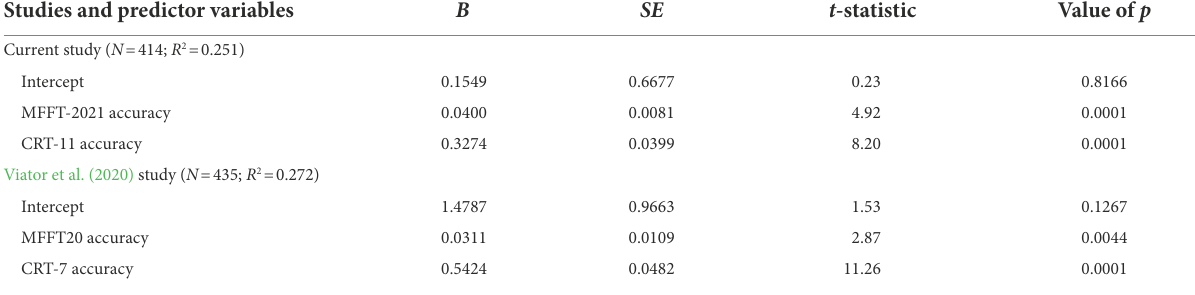
TABLE 4 Study 1 Regression analysis of heuristics-and-biases